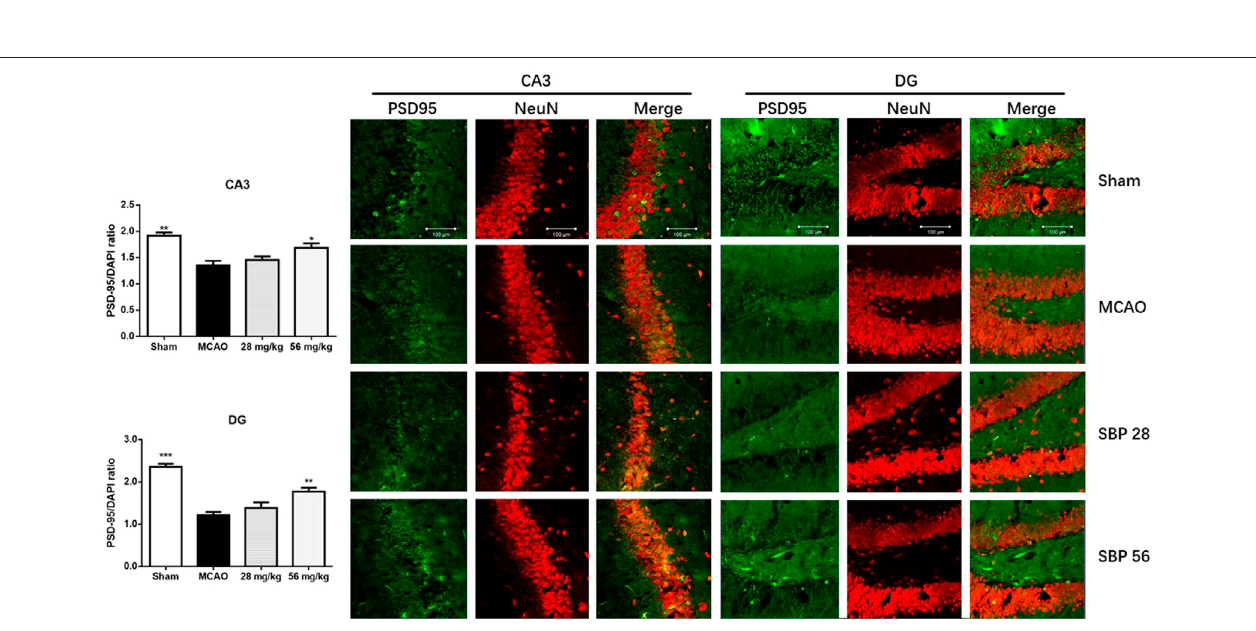
Frontiers in Pharmacology |